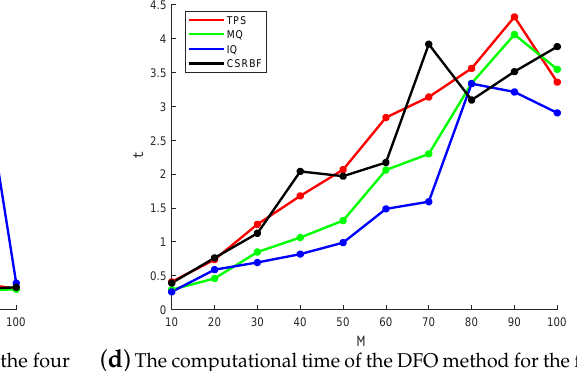
( a ) The computational time of the DFO method for the four kinds of basis functions to approximate g 1 ( x , y ) .